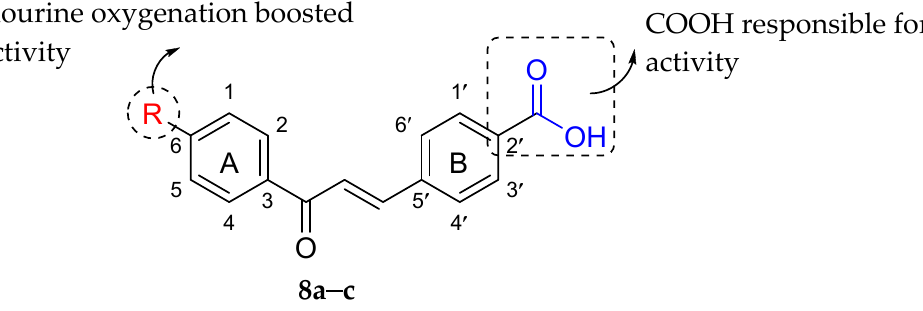
Figure 24. SAR of chalcones against S. aureus [92].